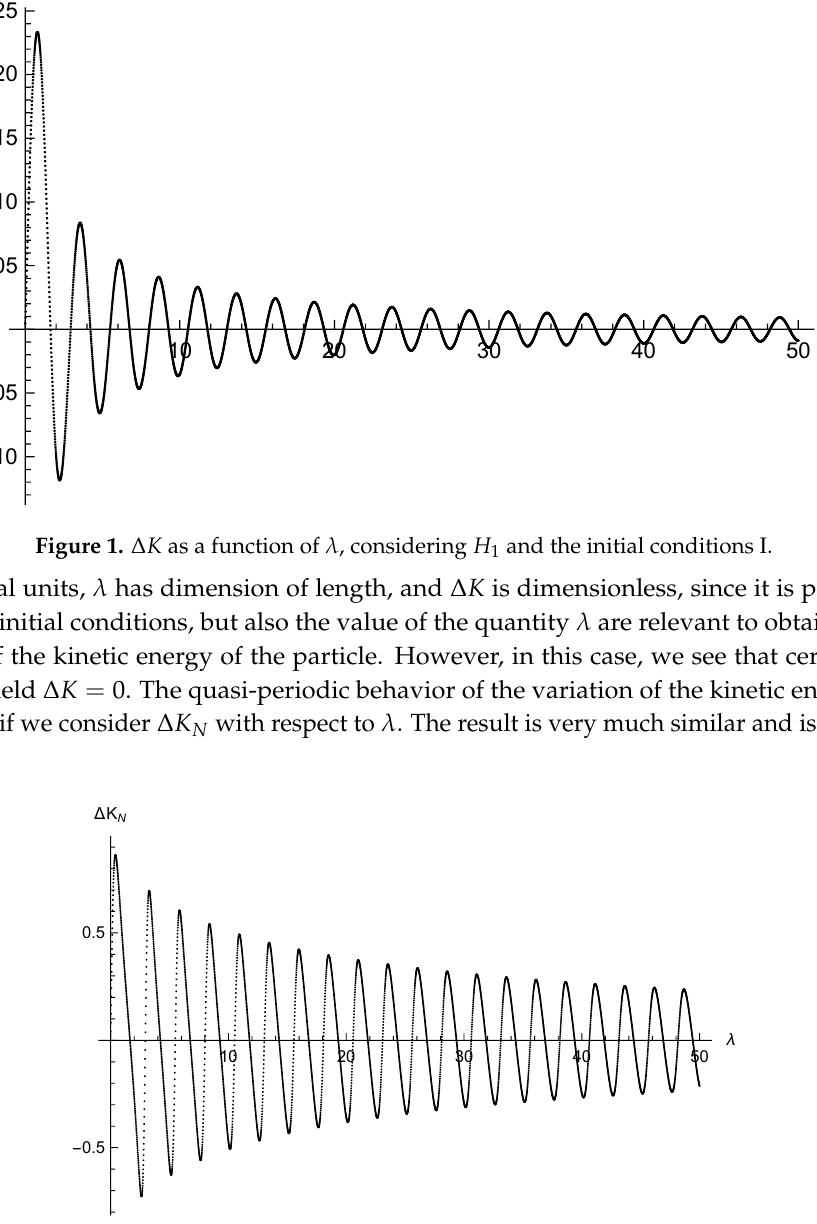
Figure 2. ∆ K N as a function of λ , considering H 1 and the initial conditions